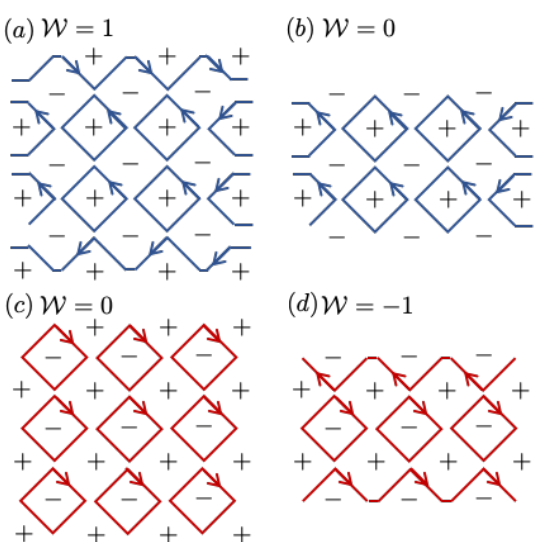
Figure 7: (a,b): Two different edge terminations for a Chalker-Coddington network model at a given energy, ε > 0. In the termination in panel (a), the horizontal strip has a chiral edge state, whereas the termination in panel (b) does not. (c,d): The same network model with two edge terminations, at an energy ε < 0 (across the transition). In the edge termination of (a,c), the winding number goes from 0 to 1 as ε increases through zero, whereas in the termination of (b,d), the winding number changes from − 1 to